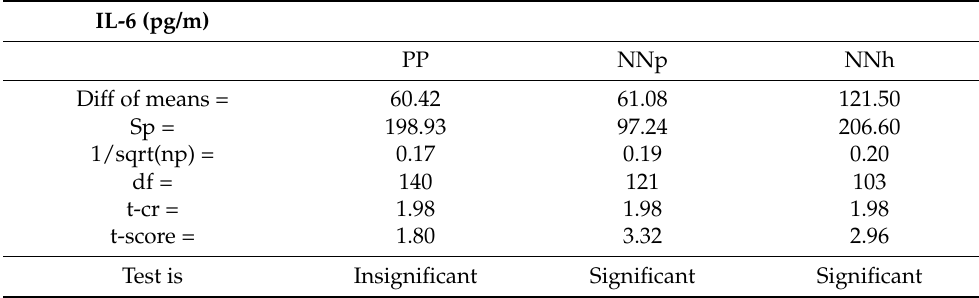
Table 3. The Student’s t -test for differences of the IL-6 mean values in PP vs. NNp, PP vs. NNh, and NNp vs. NNh groups. The difference of the mean levels of IL-6 in COVID-positive (PP) NNp groups is statistically insignificant, but the difference of the mean values of IL-6 in the NNh group and the PP and NNp groups was statistically significant.